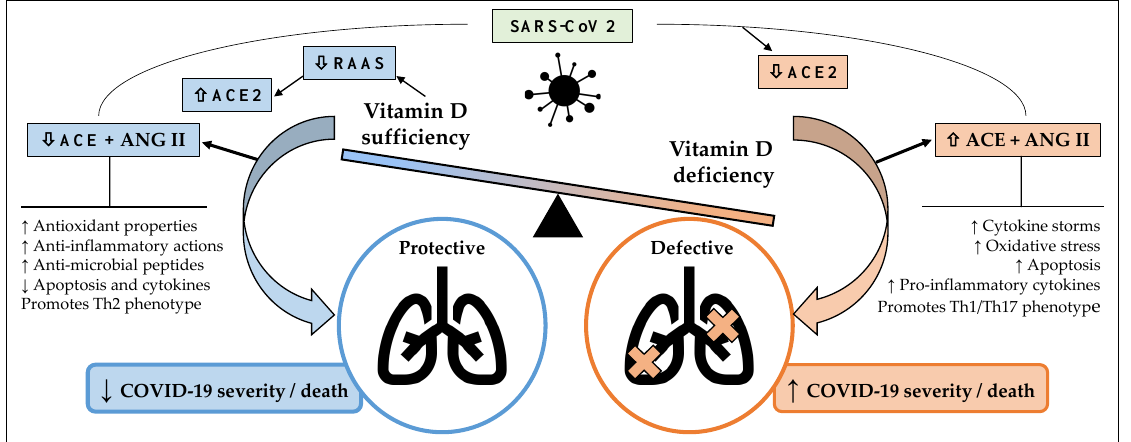
Figure 1. Potential mechanisms by which sufficient serum vitamin D levels may confer protective effects against coronavirus disease 2019 (COVID-19) and acute lung injury, whereas vitamin D deficiency may contribute to a defective immune response against COVID-19 and increased severity and/or mortality. ACE, angiotensin-converting enzyme; ANG, angiotensin; COVID-19, coronavirus disease 2019; RAAS, renin angiotensin aldosterone system; SARS-CoV-2 , severe acute respiratory syndrome coronavirus 2. Arrows pointing up indicate an increase; arrows pointing down indicate a